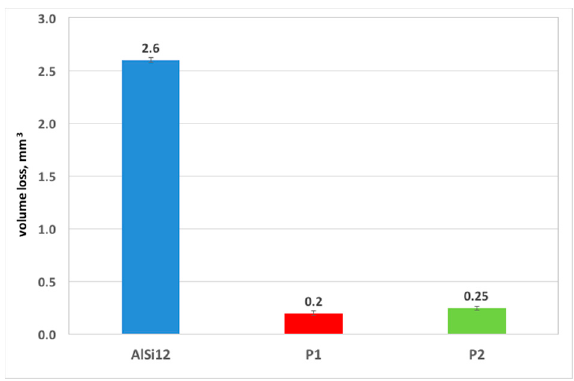
Figure 13. Volume loss of investigated interpenetrating composite layers (P1 and P2) in comparison with the unreinforced matrix area (AlSi12) in dry sliding conditions.